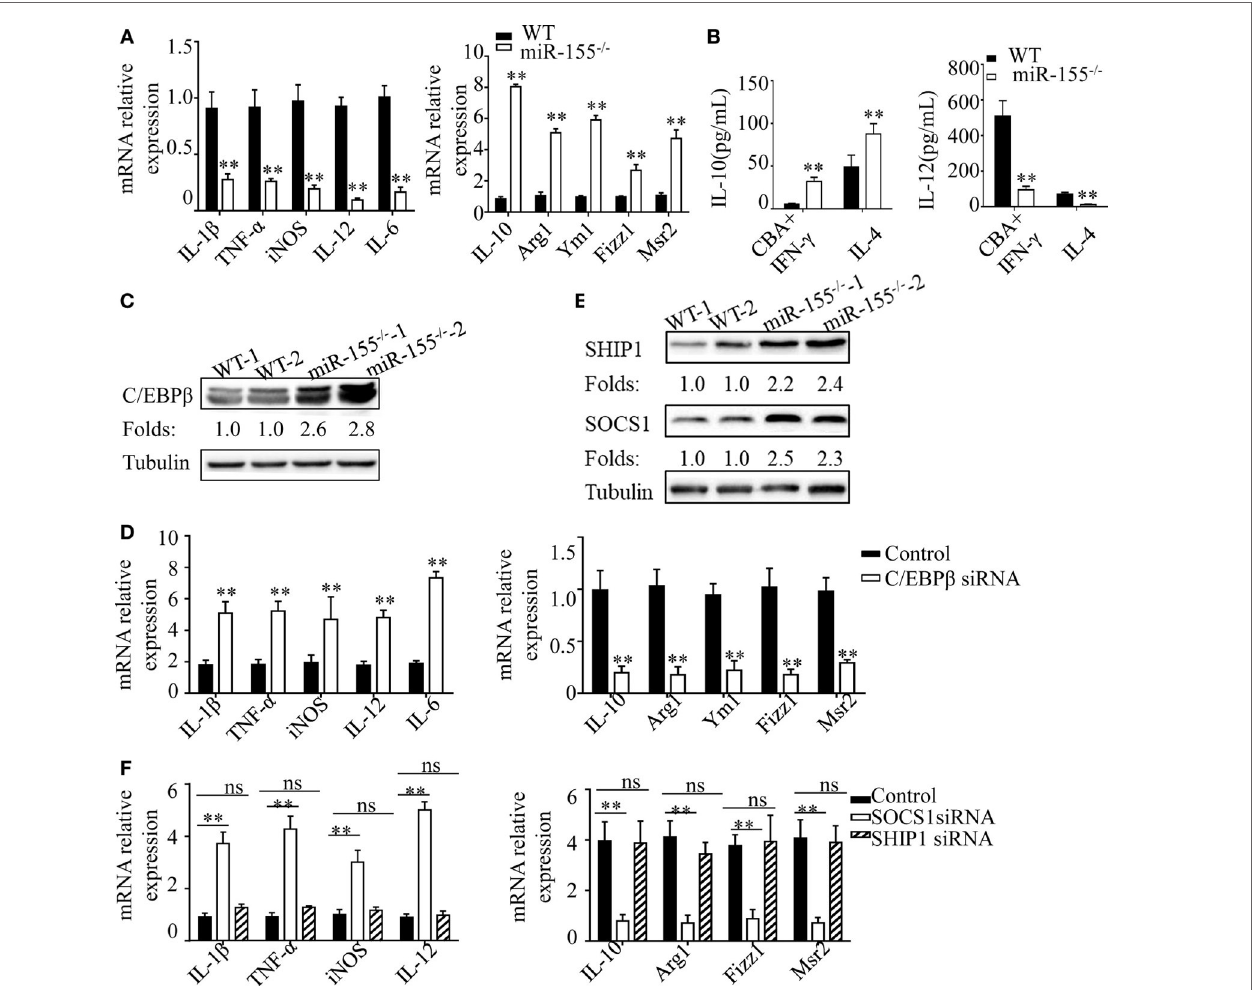
FigUre 6 | C/EBP β and SOCS1 are key functional targets in intestinal M2 polarization. (a) BMDMs isolated from WT and miR-155 − / − mice were treated with CBA (10 µg/mL) and IFN- γ (20 ng/mL), and the relative expression of M1genes and M2 genes were determined by Q-PCR. (B) The absolute amounts of secreted cytokines IL-10 and IL-12 (as representative of M2 and M1 gene products, respectively) in the supernatants of WT or miR-155 − / − BMDMs that had been treated with M1 condition (CBA + IFN- γ ) and M2 condition (IL-4) were measured by ELISA. (c) The protein expression level of C/EBP β in macrophages (CD11b + CD11c − /low ) isolated from LPMCs of dextran sulfate sodium colitis mice were determined by western blotting. (D) miR-155 − / − BMDMs were transferred with C/EBP β siRNA or control and then stimulated with CBA (10 µg/mL) and IFN- γ (20 ng/mL), and the relative expression of M1genes and M2 genes were determined by Q-PCR. (e) The protein expression level of SOCS1 and SHIP1 in macrophages, as described in (c) , was determined by western blotting. (F) miR-155 − / − BMDMs were transferred with SOCS1 and SHIP1 siRNA and treated as described in (D) , and the relative expressions of M1genes and M2 genes were determined by Q-PCR. * P < 0.05, ** P < 0.01 vs WT control or siRNA control [Student’s t -test in (a,B,D) ]. * P < 0.05, ns > 0.05 vs. siRNA control (ANOVA with Bonferroni’s posttest correction for multiple comparisons in (F) . Data are representative of three independent experiments (mean and SD). Ns, not significant. BMDMs, bone marrow-derived macrophage. WT, wild-type. CBA, cecal bacterial